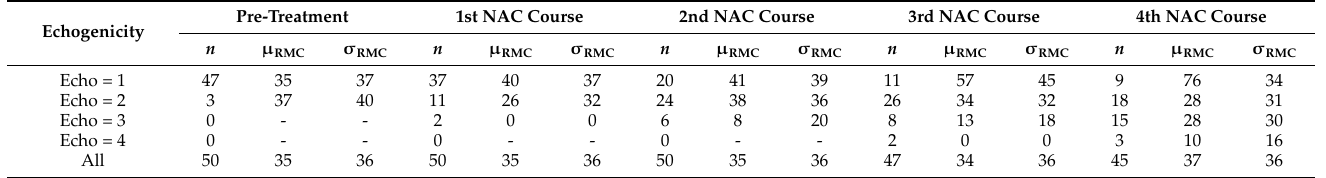
Figure 4. Alteration of echogenicity (Echo) after subsequent courses of NAC in reference to RMC assessed after treatment. Table 2. Average ( µ RMC) and standard deviation ( σ RMC) of RMC in relation to echogenicity after successive courses of